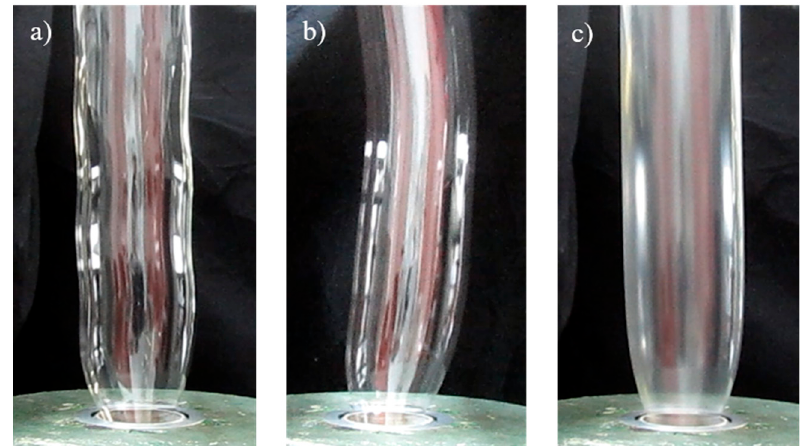
Figure 8. Image of ( a ) an axisymmetric periodic variation of the bubble diameter, ( b ) a helical motion of the bubble, and ( c ) a stable bubble. Images ( a ) and ( b ) show the neat PET and ( c ) the PET-P0.25 sample. The processing conditions are listed in Section 2.4.